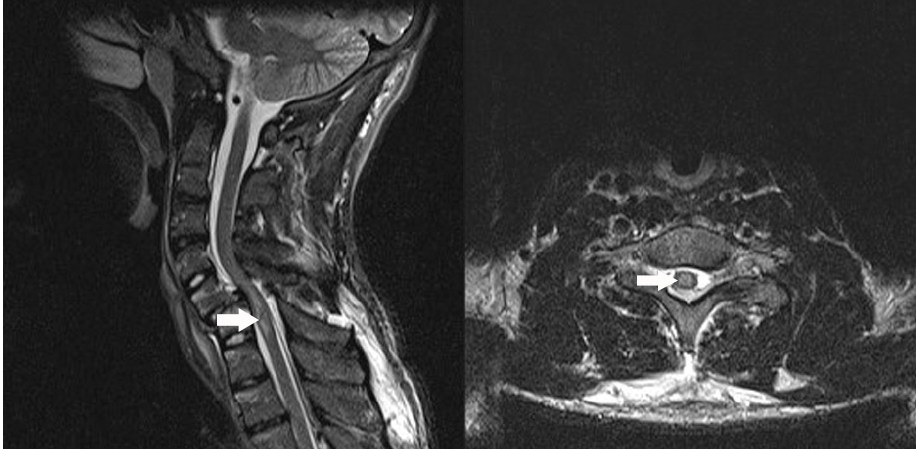
Figure 1. In spinal cord Magnetic Resonance Imaging (MRI) of patients who suffered traumatic spinal cord injury (TSCI), spinal cord hemorrhage and edema were characterized by increased T2-weighted signal within 72 h of injury. This non-contrast T2 weighted, short tau inversion recovery (STIR) sequence MRI depicts the sagittal and axial cross sections of a 17-year-old male 8 h after suffering from a ski accident. White arrows which depict increased T2 signal within the spinal cord indicate edema consistent with traumatic spinal cord injury (TSCI).